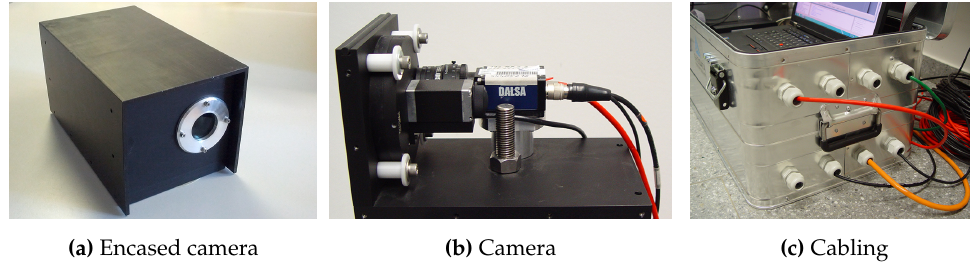
Figure 24. Robust and dampness proof encasement of cameras and base